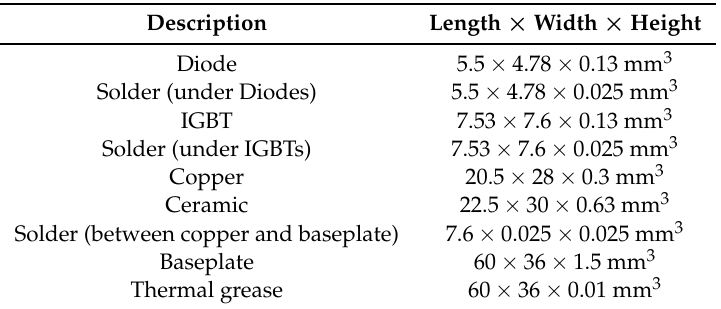
Table 2. Geometric values of layers of IGBT module.